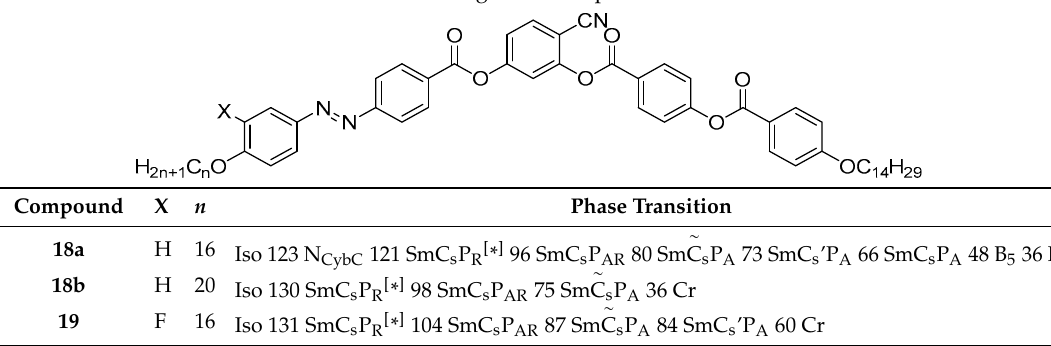
Figure 5. Optical textures of compound 16a : ( a ) observed under polarizing optical microscope (POM) between crossed polarisers at the given temperatures in the distinct phases in a planar cell (6 µm polyimide (PI) coated indium tin oxide (ITO) cell). The insets represent the corresponding textures in a homeotropic cell, ( b ) optical textures of compound 16b in the homeotropic cell (6 µm PI coated ITO cell) and its switching current response curve on applying a triangular wave field and ( c ) optical textures of compound 17 in the homeotropic cell (6 µm PI coated ITO cell) and its switching current response curve on applying a triangular wave field (Reproduced with permission from ref. [91], copyright John Wiley and Sons 2019, https://doi.org/10.1002/chem.201806180). Table 3. Phase transition of homologues of compounds 18 and their derivative 19 .